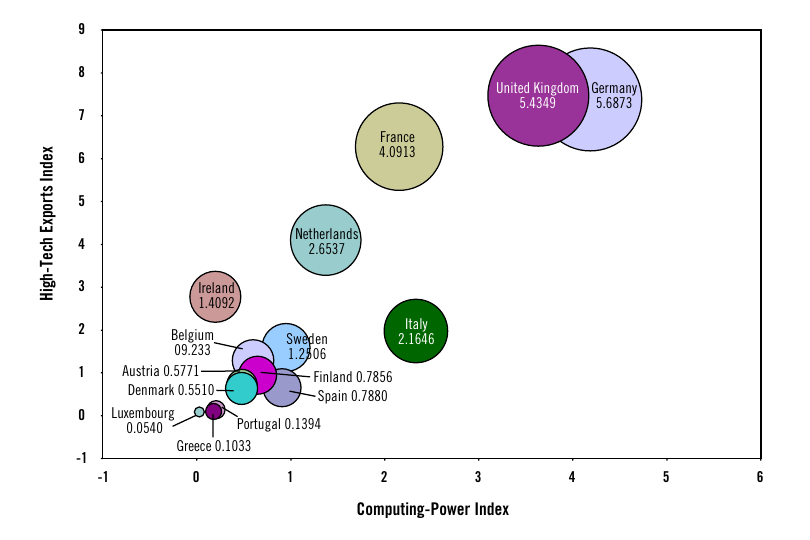
Figure 3 – Center Cluster: European Union